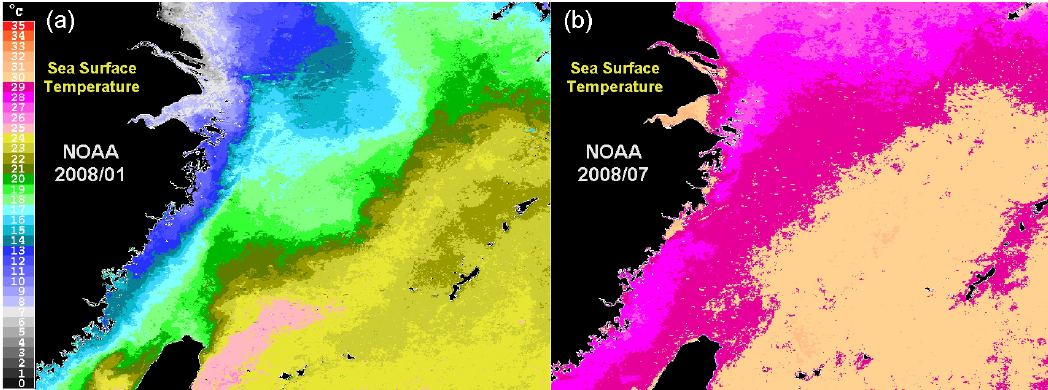
Fig. 2. Satellite images of monthly mean sea surface temperature in the ECS in the months of January and July 2008.